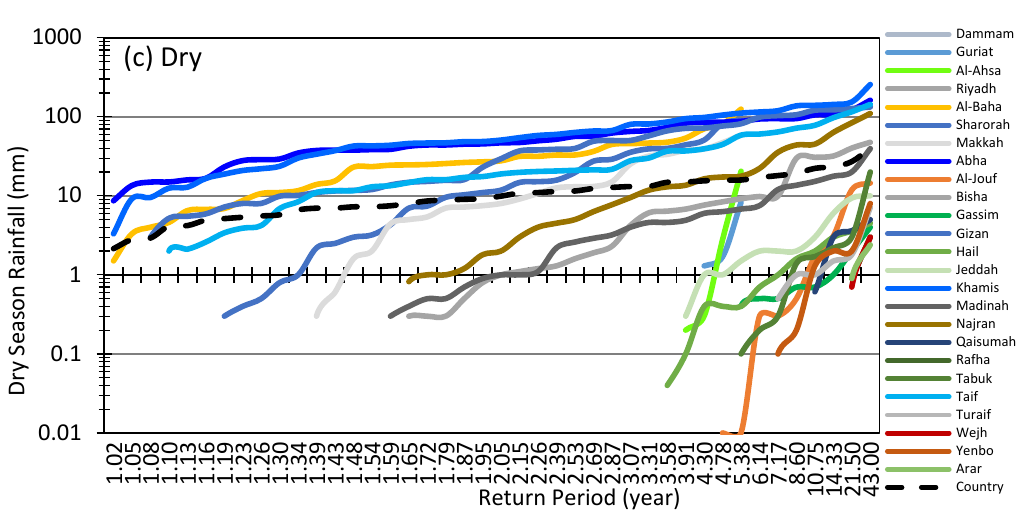
Figure 13. The depth–duration–frequency curves of the return periods for the ( a ) annual, ( b ) wet season, and ( c ) dry season rainfall at different stations averaged for the period 1978–2019. Rainfall amounts on the vertical axis are in a logarithmic scale.